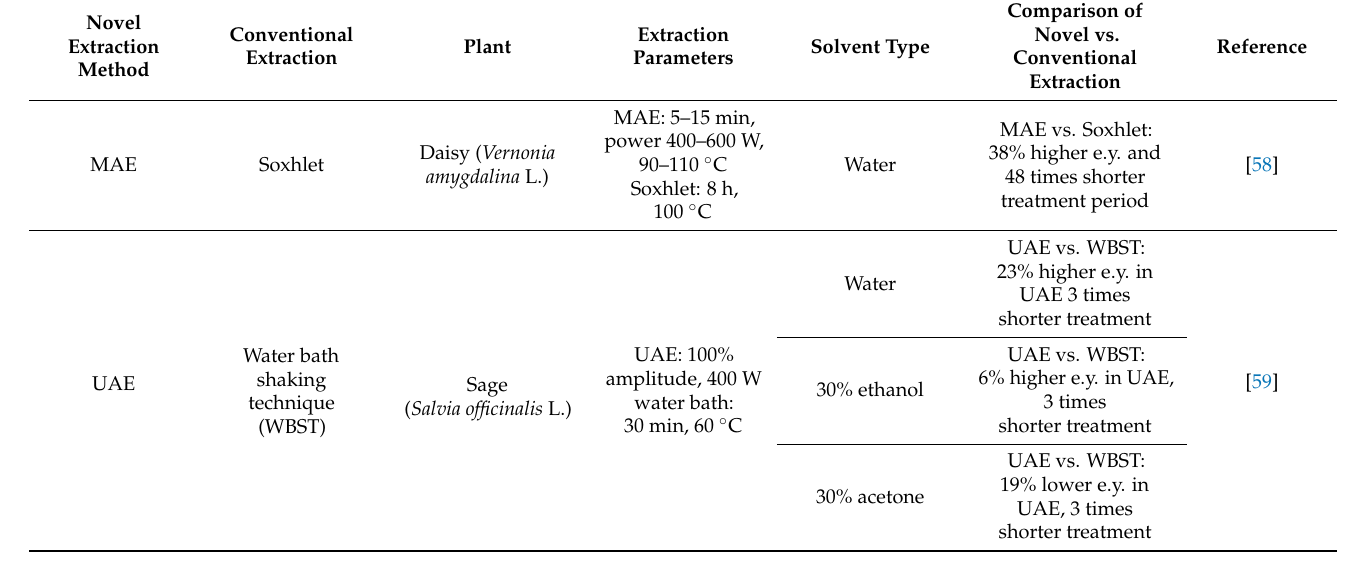
Table 1. Comparison of novel and conventional extraction methods of polyphenols from